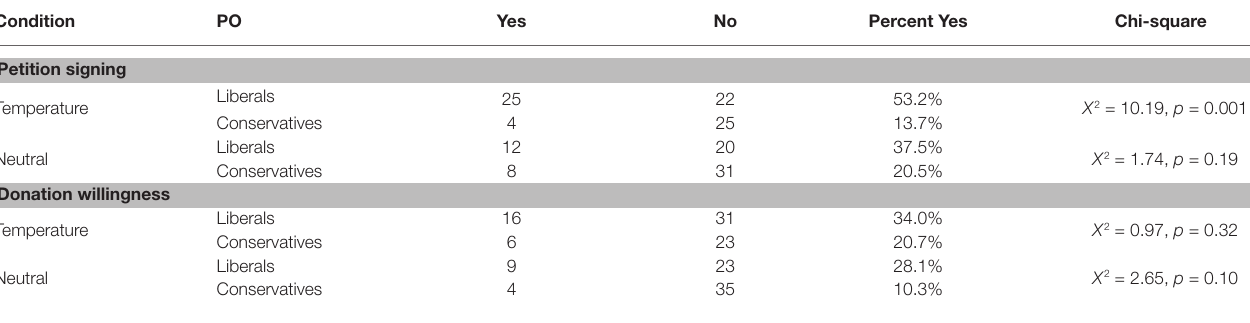
TABLE 1 | The number of liberals and conservatives who signed the petition or were willing to donate in the temperature condition and the neutral condition. Condition